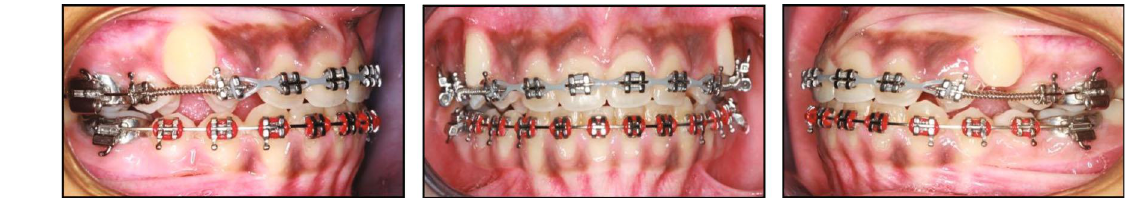
Figure 8: Powerchain from the upper right fi rst premolar to left fi rst premolar to close diastema.